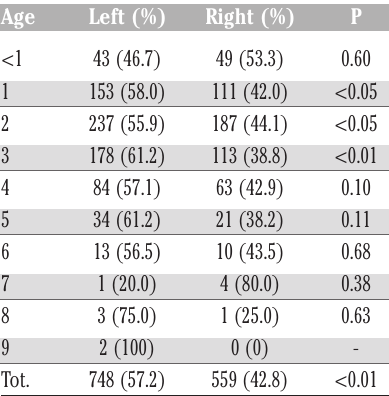
Table 2. The rate of injury per affected arm/age